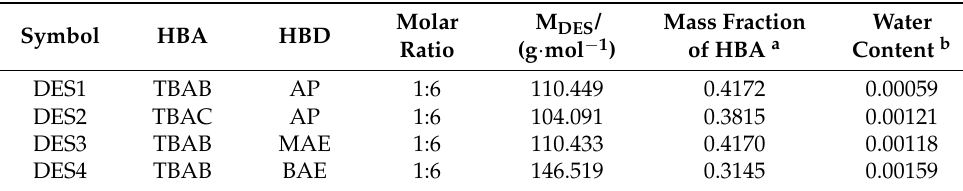
Table 2. Abbreviations of chemicals and DESs along with their molar mass, molar ratio, mass fraction, and water